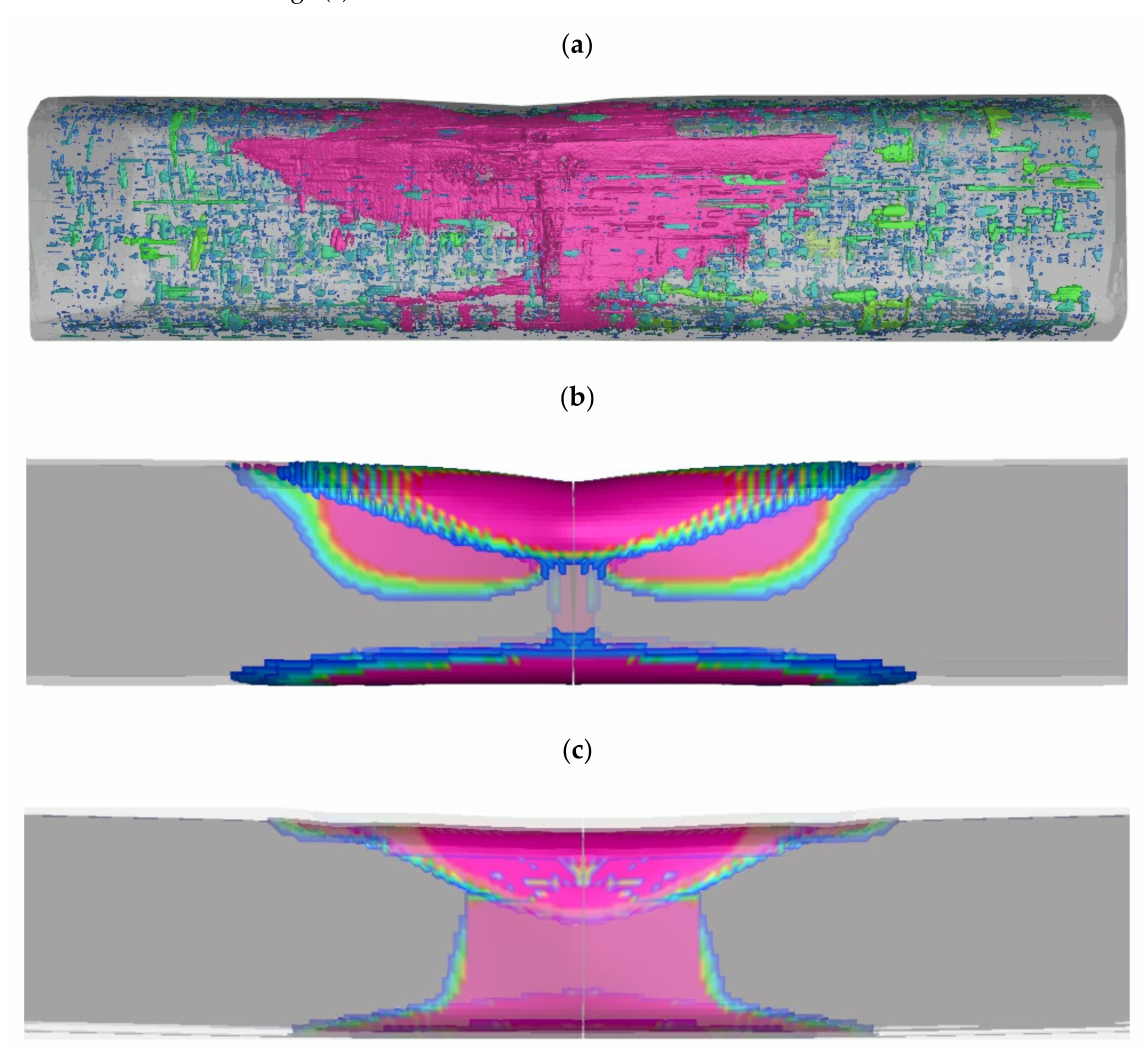
Figure 10. Delamination in the central 100 mm-long segment of the crushed [0 4 , 90 3 ] S specimen: CT-scan vs. numerical modeling. ( a ) X-ray computed tomography; ( b ) MAT54 model: delamination (overlayed images); ( c ) MAT58 model: delamination (overlayed